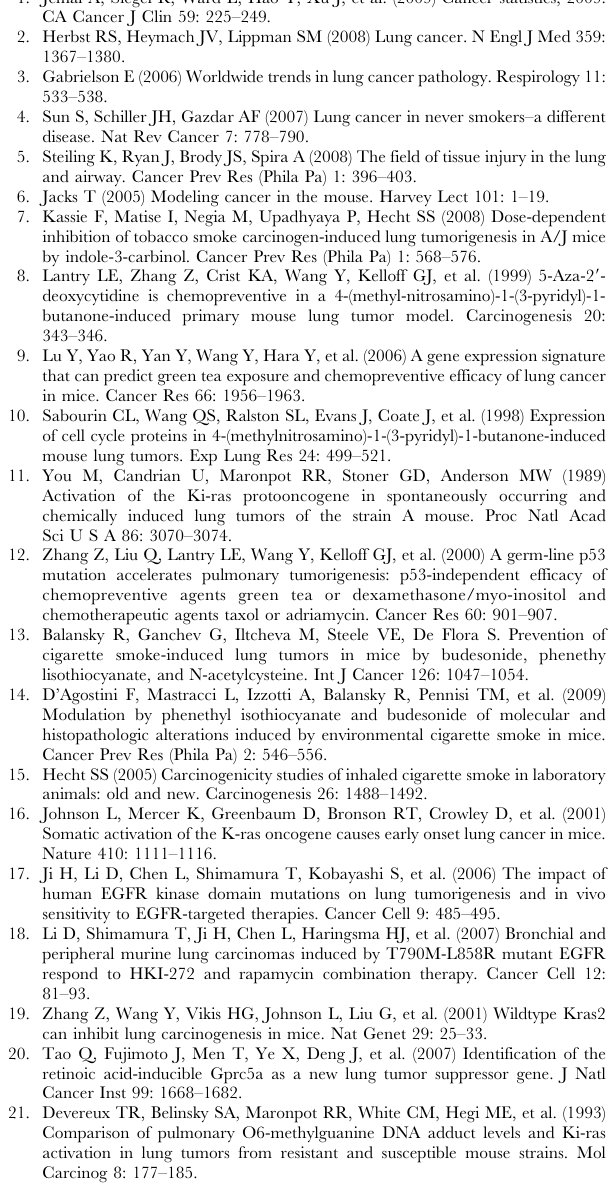
Found at: doi:10.1371/journal.pone.0011847.s001 (0.15